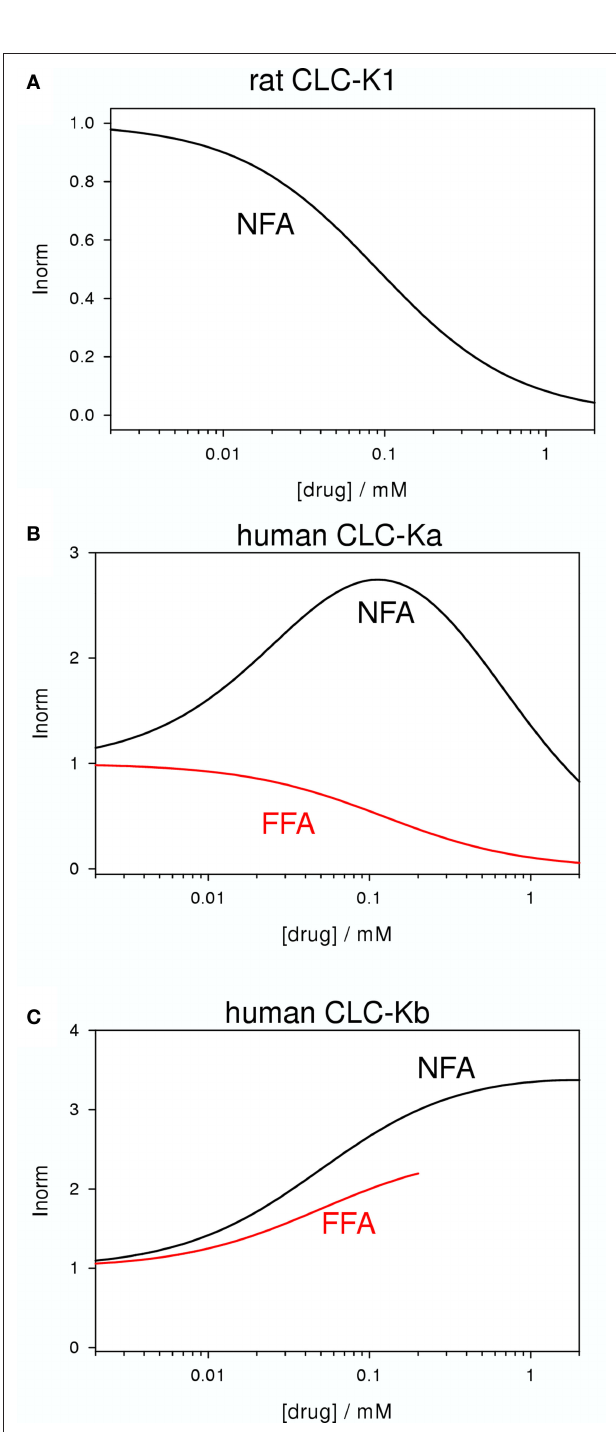
Figure 5 | Blocking and potentiating effects of NFA and FFA on various CLC-K homologs (A: CLC-K1, B: CLC-Ka, C: CLC-Kb). The effect of NFA is schematically drawn in black, whereas the effect of FFA is shown in red. No measurements with FFA on CLC-K1 have been